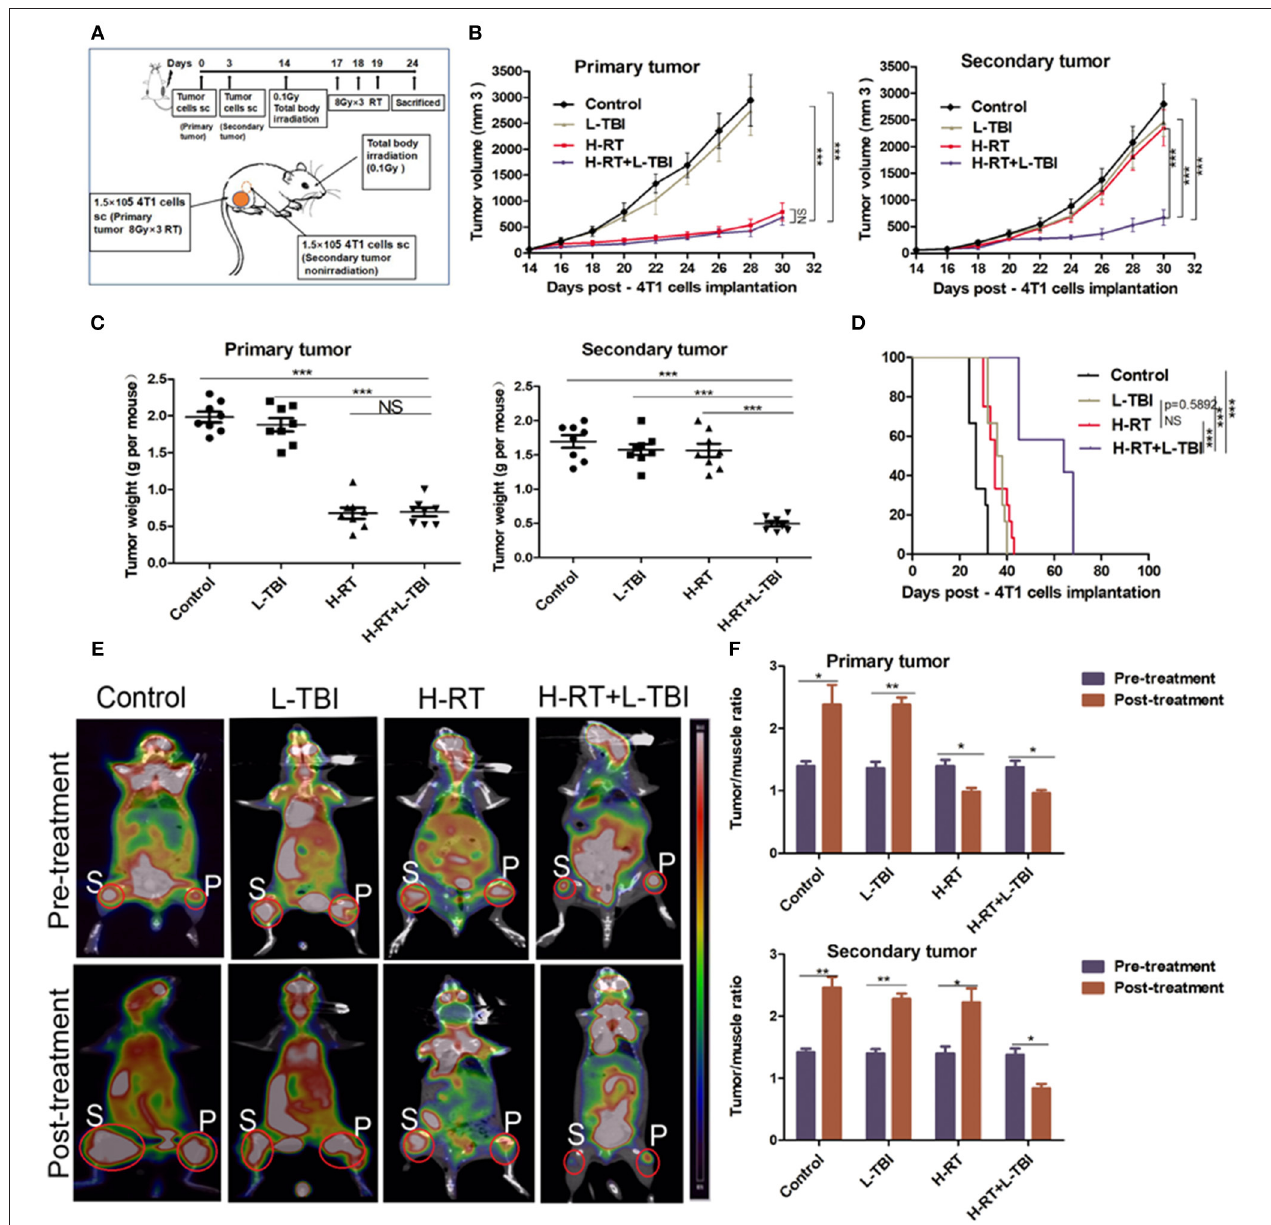
FIGURE 1 | H-RT on 4T1-derived subcutaneous tumor combined with L-TBI. (A) Experimental groups were treated as represented in the timeline. Immunocompetent mice were injected s.c. with syngeneic 4T1 cells (1 × 10 5 ) into the right (primary tumor) and left (secondary tumor) flank, respectively. H-RT was administered locally to the primary tumor from day 17 to 19, and L-TBI was administered on day 14. Primary and secondary tumor volumes were measured. On day 24, mice were sacrificed and tumors weighed. (B) Tumor growth of primary tumors (right panel) and secondary tumor (left panel) in mice treated with control (black line), H-RT (yellow line), L-TBI (red line), and combination of the H-RT and L-TBI (blue line). Data are the mean ± SE of 12 mice/group. (C) Primary tumor weight (right panel) and secondary tumor weight (left panel) on day 24 ( n = 8 mice/group). (D) Overall survival of the tumor bearing mice of different treatment groups ( n = 12 mice/group). (E) Representative pre- and post-treatment 18F-FDG PET images of tumor-bearing mice in control, and treatments groups (L-TBI, H-RT, H-RT + L-TBI; n = 5 mice/group). (F) Tumor/muscle ratio of primary (right panel) and secondary (left panel) tumor in the pre-treatment (on day 13) and post-treatment (on day 24) period ( n = 5 mice/group). The experiment has been repeated in similar result (* P < 0.05, ** P < 0.01, *** P < 0.001 and NS = not significant).